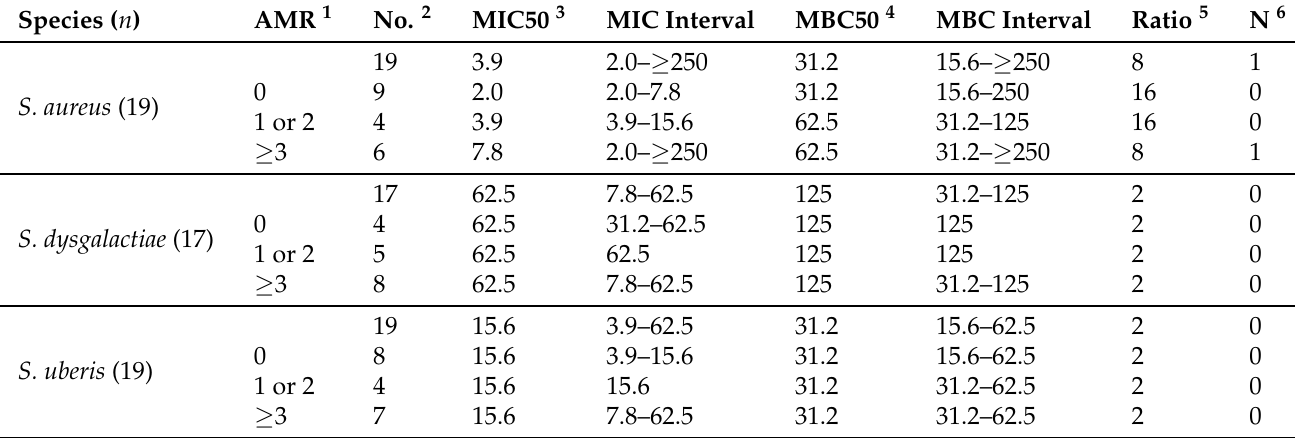
Table 4. MIC and MBC intervals, as well as MIC50 and MBC50 ( µ g/mL) values, of bactofencin against Staphylococcus and Streptococcus causing